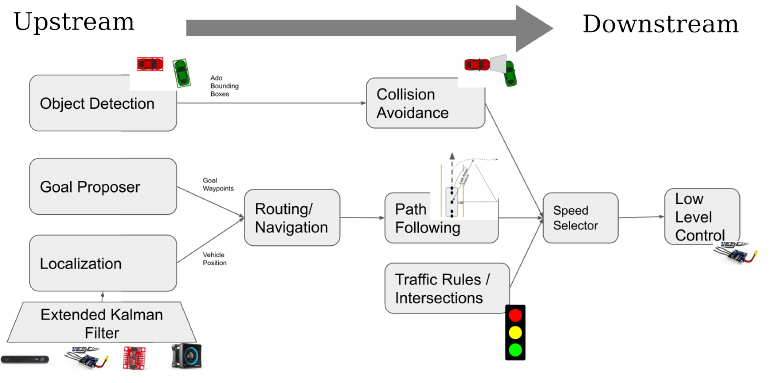
Figure 8. RACECAR AV Software Stack.